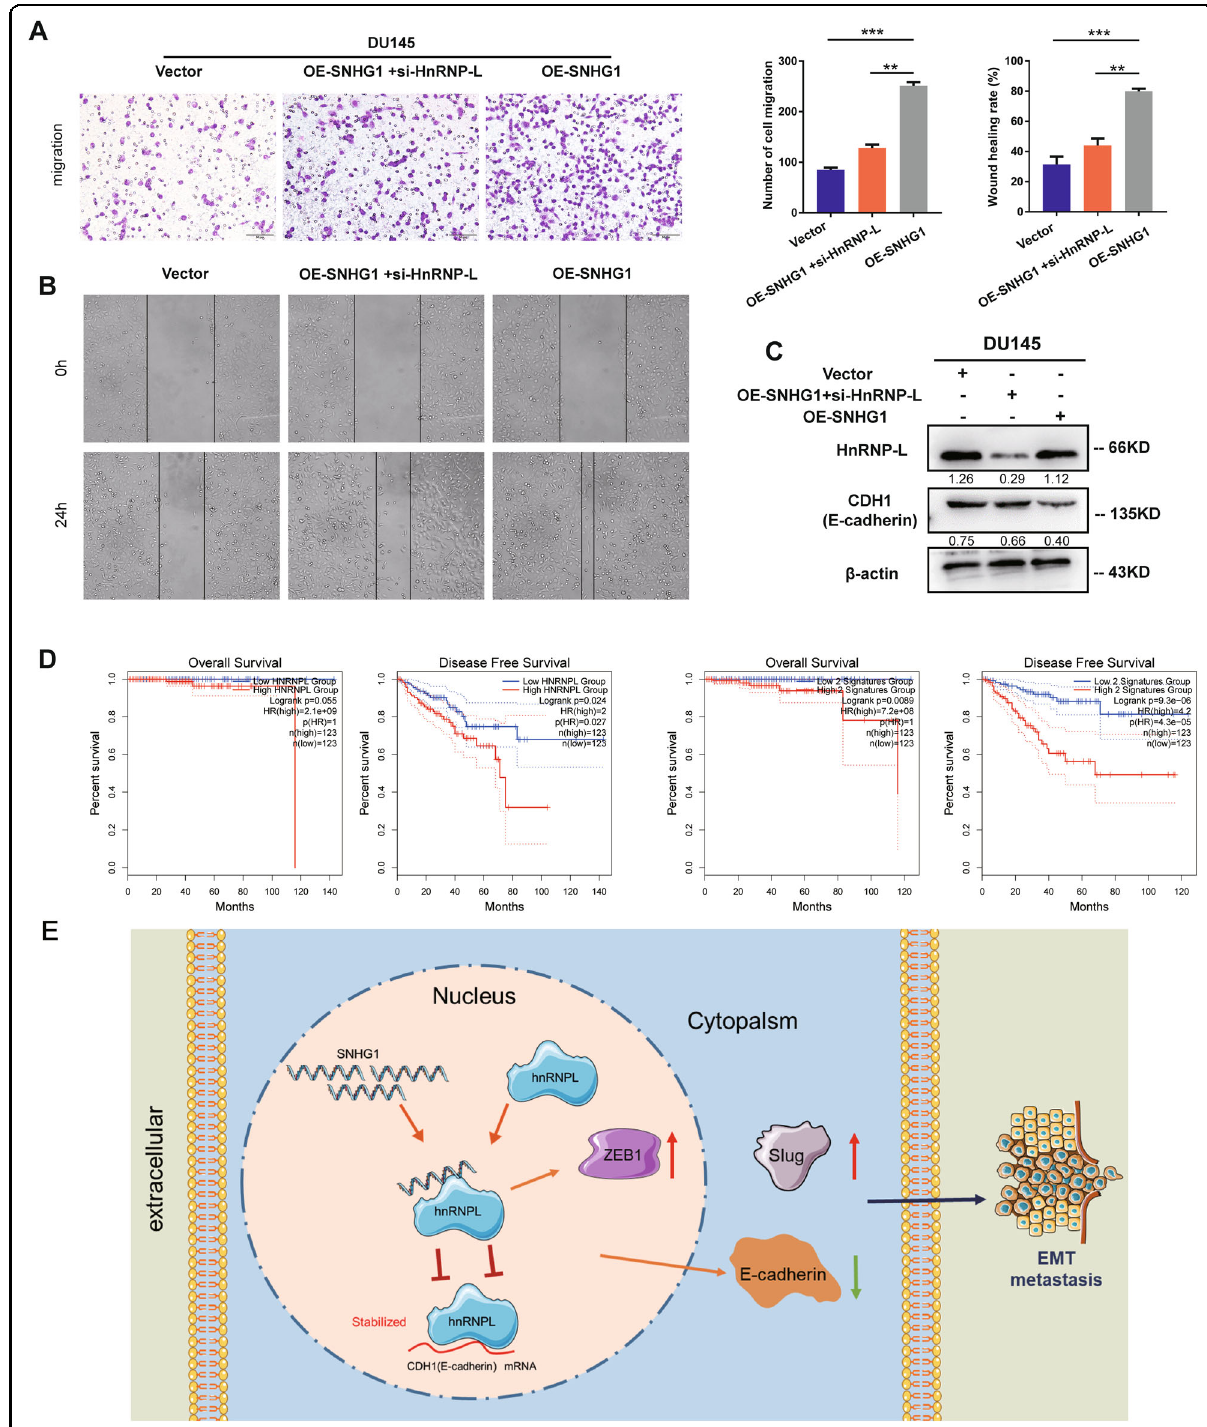
Fig. 6 HnRNPL knocdown reverses the carcinogenic effects of SNHG1 promotion on cell metastasis. A , B HnRNPL knockdown reversed the SNHG1 overexpression-induced cell migration ability in PCa cells. C western blot showed that forced expression of hnRNPL reversed the SNHG1 upregulating-induced inhibition of E-cadherin protein. D Survival analysis revealed that PCa patients with both low SNHG1 and hnRNPL expression levels had better overall survival and disease-free survival (GEPIA, http://gepia.cancer-pku.cn/). E Schematic diagram displaying the mechanism underlying SNHG1 could competitively bind to hnRNPL leading to downregulating of E-cadherin. ** P < 0.01, *** P <